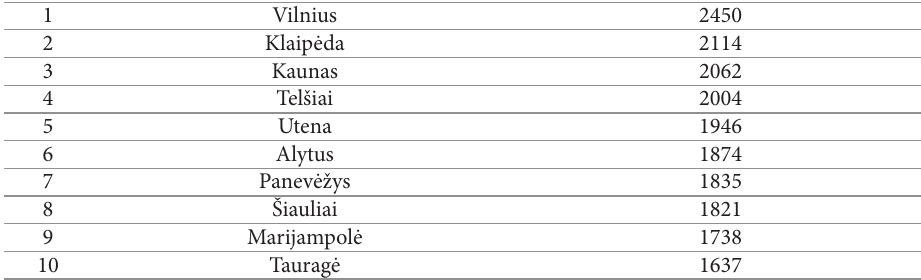
Table 3. Classification of the Lithuanian Counties by the average gross monthly earnings per capita for 2008 (in Litas) 1